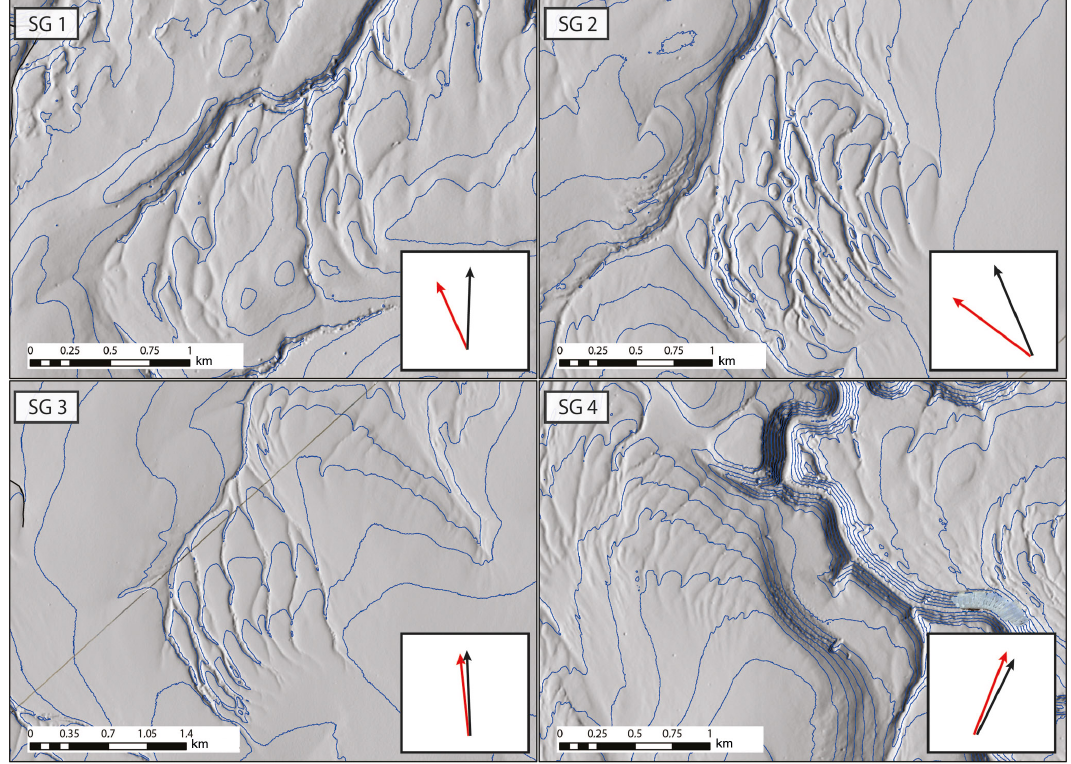
Figure 7. Hillshade and contour map of the four subglacial channel networks investigated. Contour lines are separated 15m, and hillshade resolution is 2mpixel − 1 . In the bottom right corner, the black arrows indicate the overall direction of the channels in the networks, whereas red indicates the regional slope